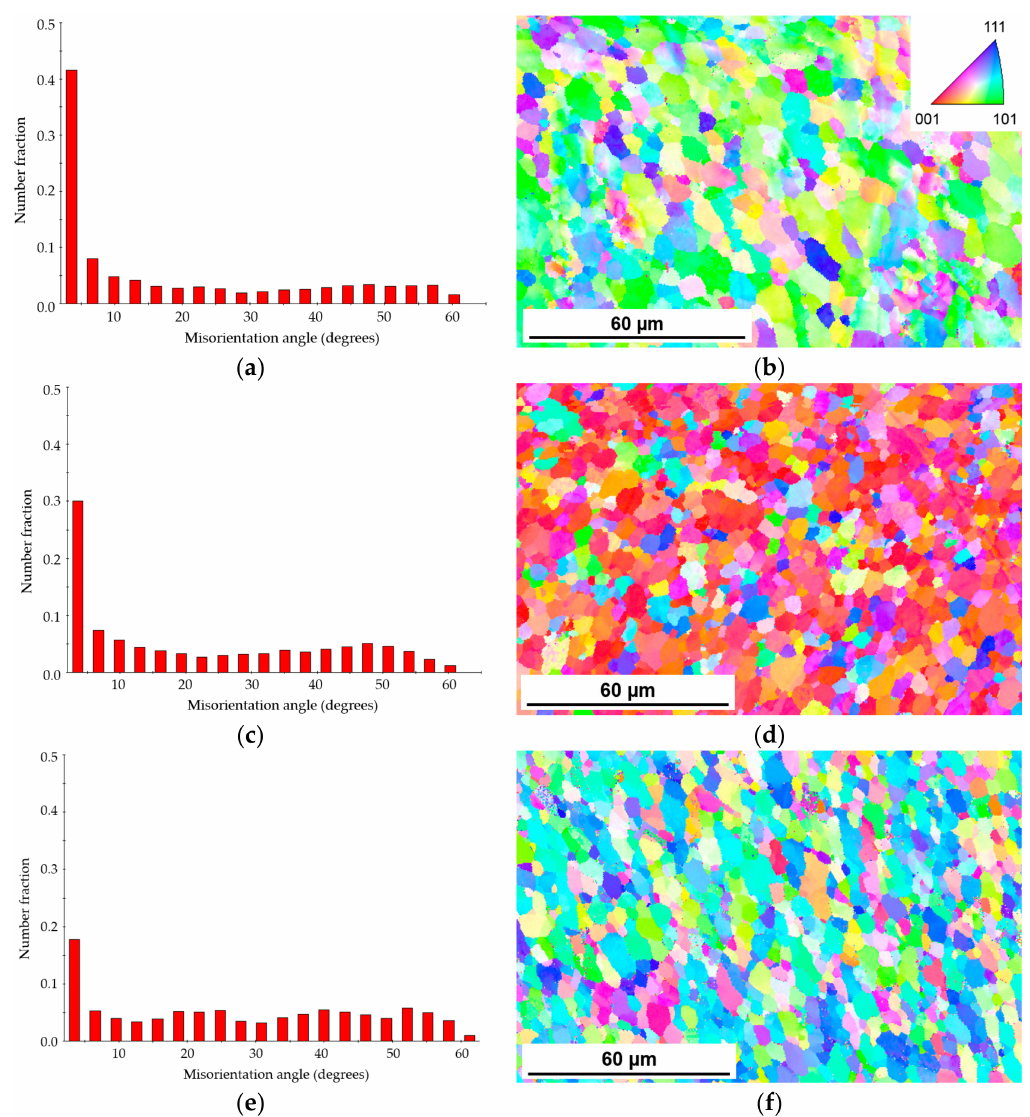
Figure 5. Misorientation angle distribution and EBSD maps in the SZ of AA6082-T6 joints: ( a , b ) FSW; ( c , d ) IFSW 2 kN 3 Hz; ( e , f ) IFSW 2 kN 10